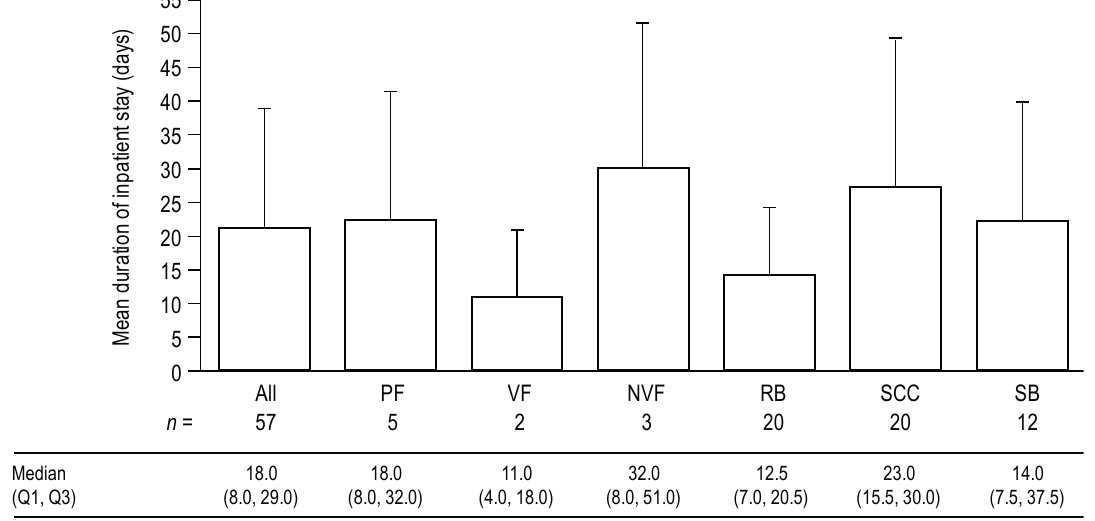
Figure 2. Mean duration of inpatient stays for each type of SRE and for all types of SRE combined. Data shown as mean (+standard deviation) duration of inpatient stays for SREs that required an inpatient stay. Median (Q1, Q3) values are displayed below the graph. If an SRE was associated with multiple inpatient stays, the total duration of all stays was used. Data for PF are shown first overall, and then by VF and NVF